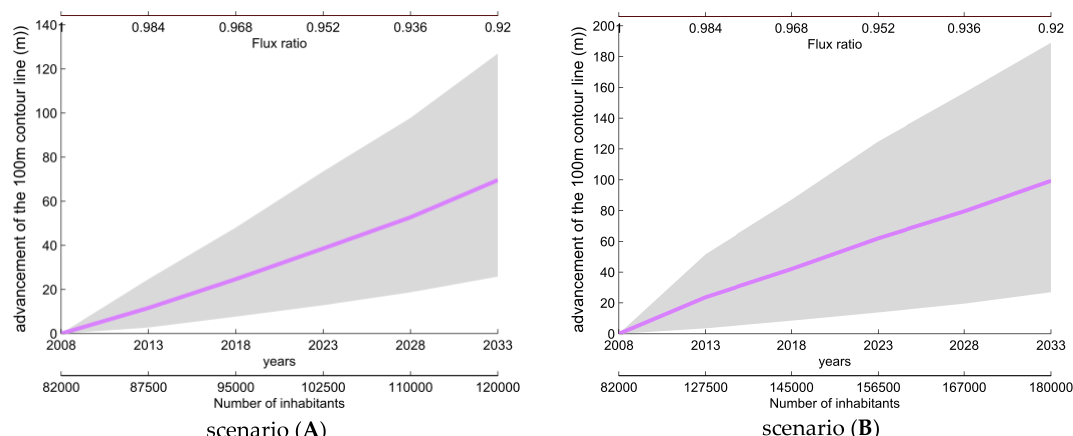
Figure 12. Advancement inland of the 100 m contour line of the seawater/freshwater interface with respect to flux ratio, years, and number of inhabitants in scenarios ( A ) and ( B ).